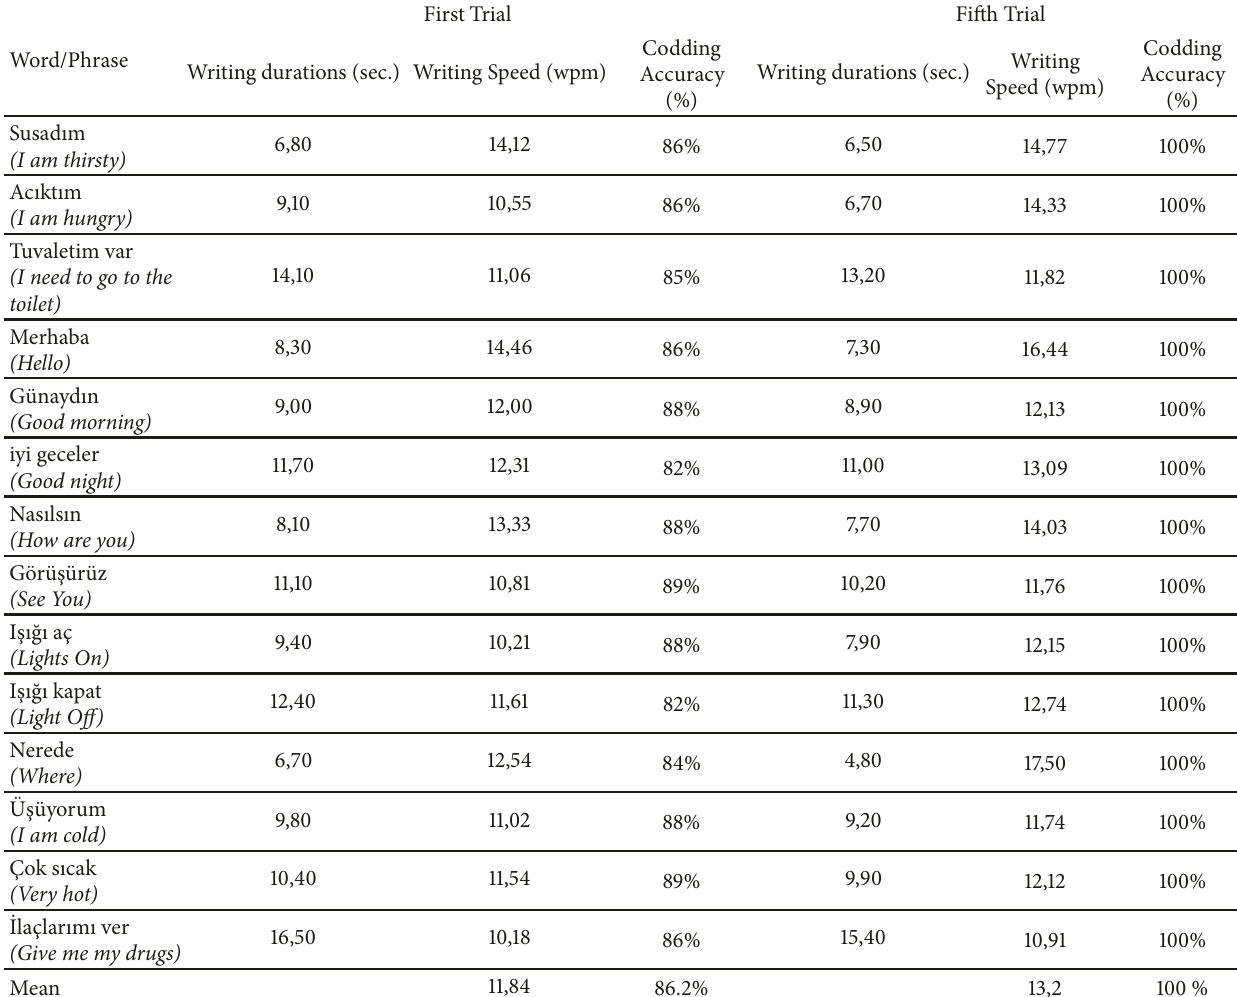
Table 2: Test results of proposed method.